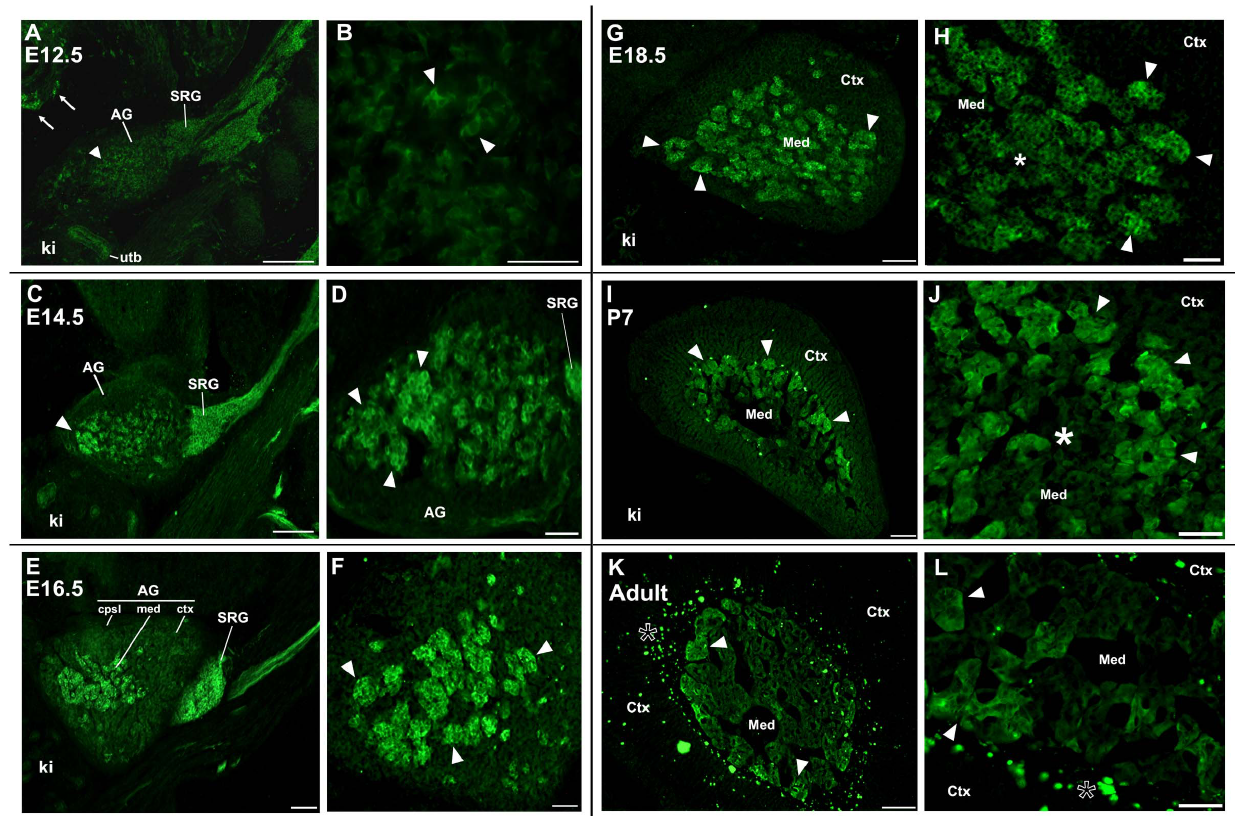
Figure 2. Expression of a 7 G in the developing mouse adrenal gland. Sagittal sections of embryos at different stages of development were prepared and immunostained for a 7 G (anti-GFP, Methods) to reveal current a 7 expression. A,B . E12.5 embryos show the developing adrenal gland (AG) adjacent to the kidney (ki). Immunostaining for GFP is seen in the AG, present in the developing adrenal gland (AG, arrow heads), the suprarenal ganglion (SRG), enteric neurons (arrows) and the ureteric buds (utb) of the kidney. At increased magnification (B), the GFP signal in the AG and SRG reveals a 7 G positive cells (arrow heads). C,D . The E14.5 AG begins to show consolidation of the cells expressing a 7 G (arrow head) and ongoing expression in the SRG. At greater magnification (D), these cells tend to be in aggregates and often appear to be of increased density in the more ventral aspect of the AG (arrow heads). E,F . An E16.5 AG and associated SRG stained for GFP. At this stage a 7 G expressing cells are in the medulla and few (if any) remain in the now recognizable capsule (cpsl) or ctx. Increased magnification (F) shows the majority of a 7 G stained cells are in well- defined aggregates within the medulla (arrow heads). G,H . At E18.5 a 7 G remains localized to well-defined cell groups in the med (arrow heads). The image on the right shows that at this stage there are also cells of reduced a 7 G intensity (asterisk) relative to those identified by the arrow heads. I,J . The post-natal day 7 (P7) adrenal gland. Cells expressing a 7 G tend to be aggregated into clusters that are localized towards the med-ctx border (arrow heads). This is particularly evident in (J) where the cell aggregates are visible while more centrally localized cells exhibit diminished or no a 7 G expression (asterisk). K,L . The adult adrenal gland a 7 G expression persisted in only a relatively few cells clustered into groups near the med-ctx boundary (arrow heads). The ‘spotted’ staining (asterisk) at this boundary interface and extending into the ctx is background fluorescence. Abbreviations: AG, adrenal gland; cpsl, adrenal capsule; ctx, adrenal cortex; ki, kidney; med, adrenal medulla; SRG, suprarenal ganglion; utb, ureteric bud. Scale bars =100 m m (A,B,C,E,G,I,K) or 50 m m